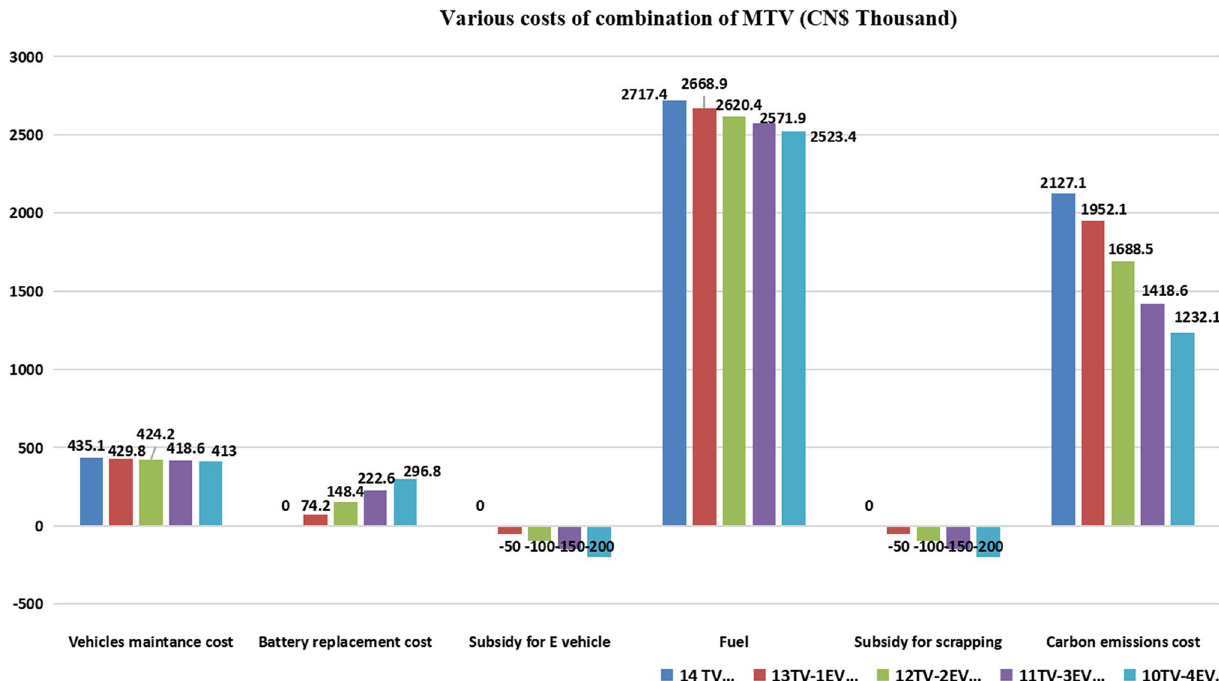
Figure 4. Comparison of various costs of different combinations of MTV.